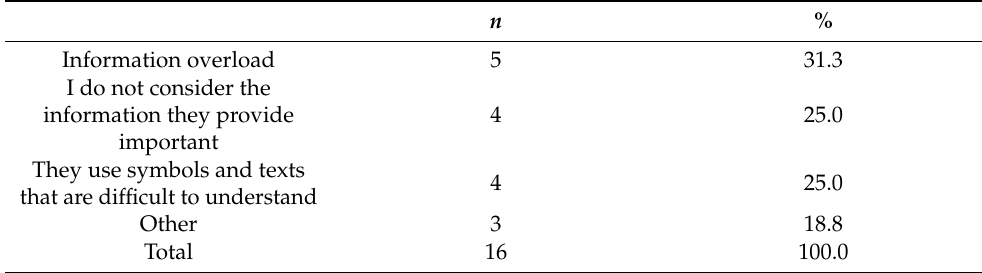
Table 5. Reasons for not reading food product